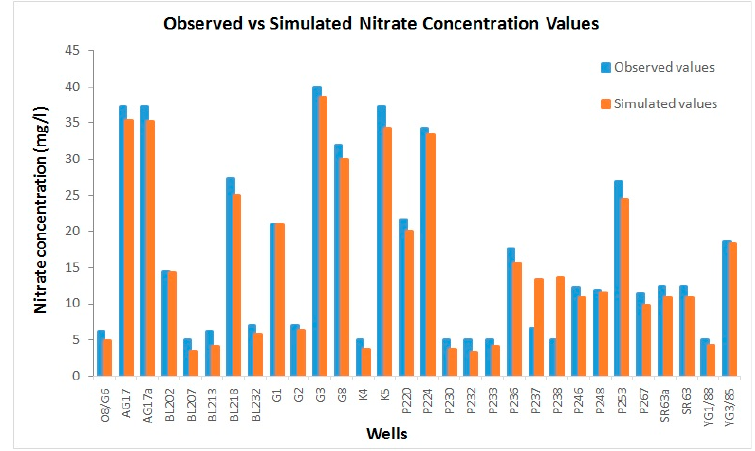
Figure 5. Comparison of the observed and simulated nitrate concentration values.